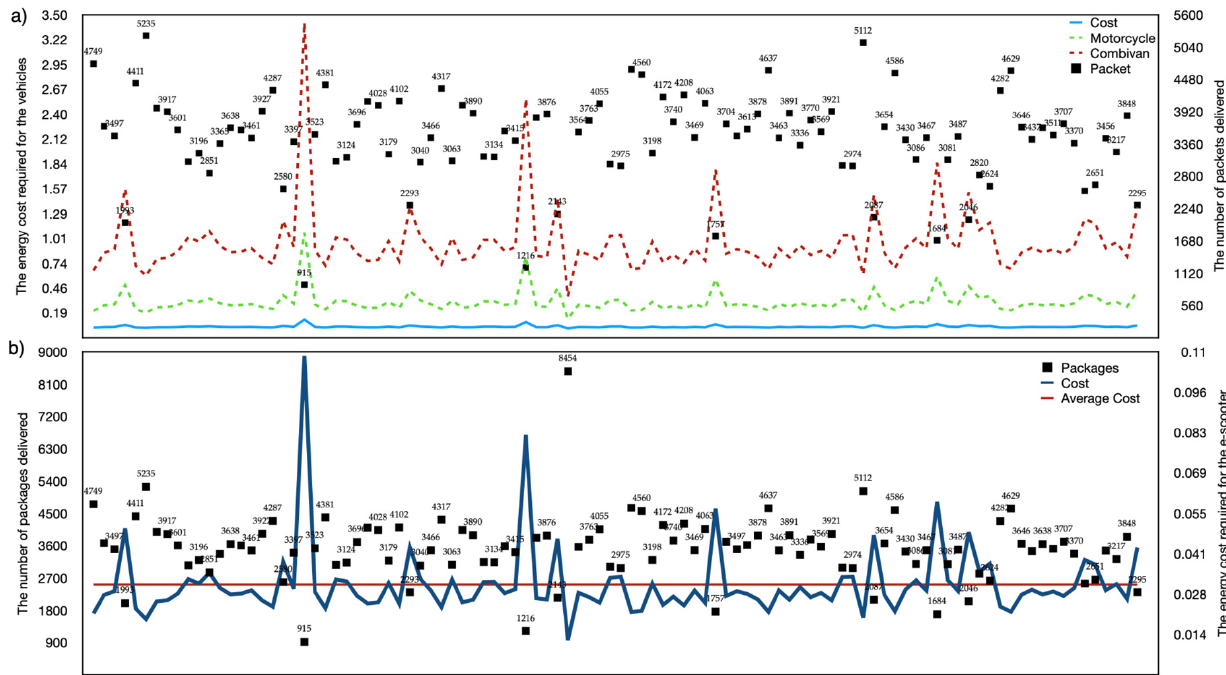
Figure 5. ( a ) The cost of energy required for a package delivered, ( b ) The number of packages or mails distributed with the e-scooter micro-mobility.